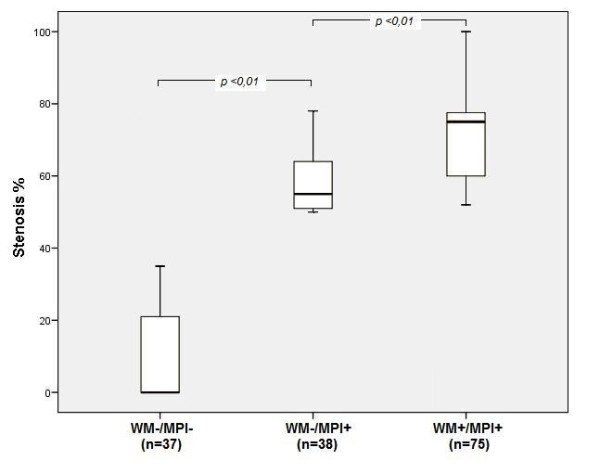
Average stenosis diameter. Average stenosis diameter in patients who underwent QCA, classified into three subgroups based on SE results: MPI-/WM-, MPI+/WM-, MPI+/WM+. Abbreviations as defined in table 1.